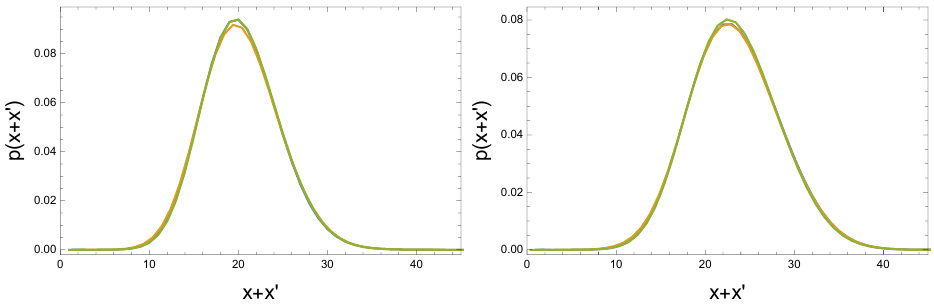
Figure 8. Distributions of p ( x + x (cid:48) ) (blue), p ( y + y (cid:48) ) (green) and p ( z + z (cid:48) ) (orange) for systems with N { 4,1 } = 80 k (left) and N { 4,1 } = 160k (right) and T = 4. One can show that the distributions scale (cid:0) (cid:1) 1/4 N ( 4,1 ) as